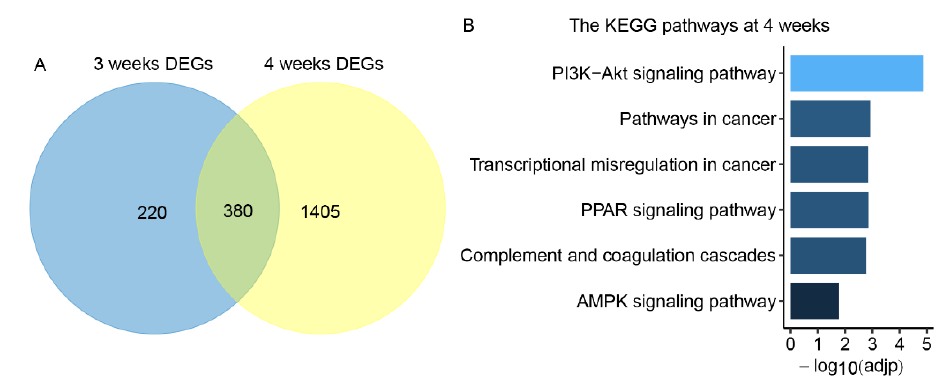
Figure 2. The differentially expressed genes (DEGs) and enriched pathways in GK skeletal muscle. ( A ) Venn diagram of differentially expressed genes in GK skeletal muscle compared to age-matched Wistar rats at three and four weeks of age. ( B ) The Kyoto Encyclopedia of Genes and Genomes (KEGG) pathways enriched in GK skeletal muscle at four weeks (Benjamini correction of P < 0.05). Adjp represents the Benjamini correction of P values.